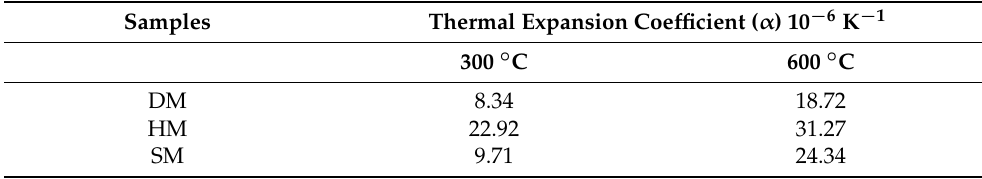
Table 4. Thermal expansion coefficients of DM, HM, and SM specimens.